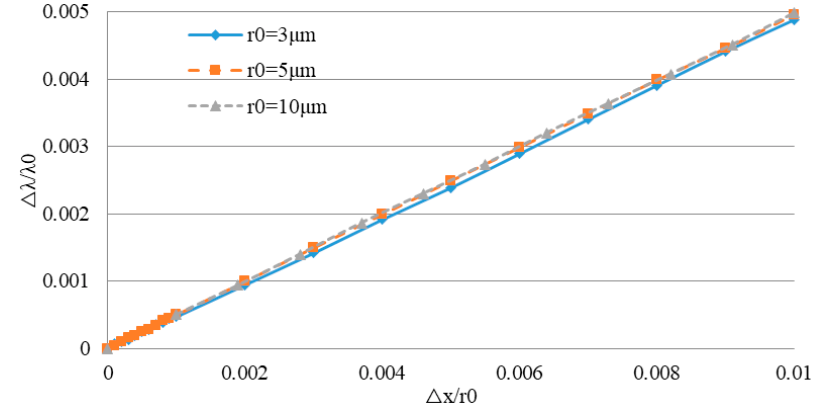
Figure 11. Relationship between △ x / r 0 and △ λ / λ 0 in WGM resonators with different initial radii.